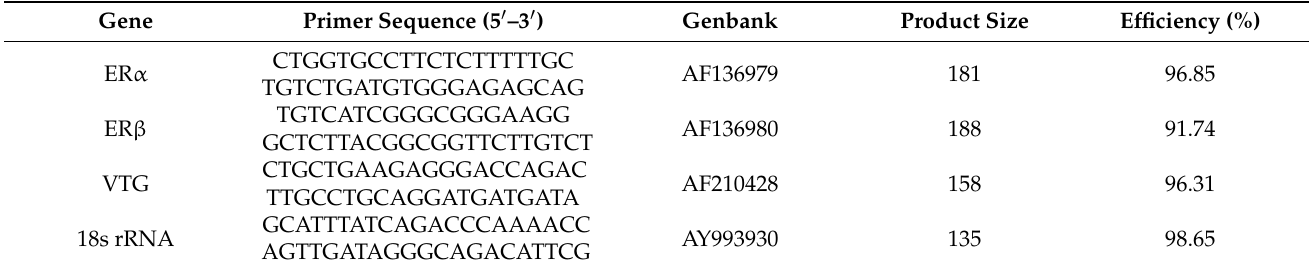
Table 1. List of primers used in this